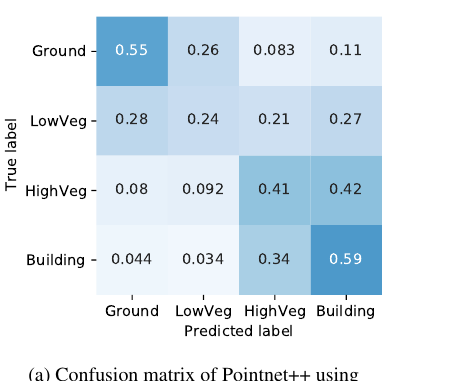
(b) Confusion matrix of MeshCNN using geometric features only Figure 3. Confusion matrices using geometric features only. Both models show a rather weak predictive performance. Without texture information, the models struggle to distinguish buildings from high vegetation and ground from low vegetation, which is not least caused by the comparably poor mesh quality.